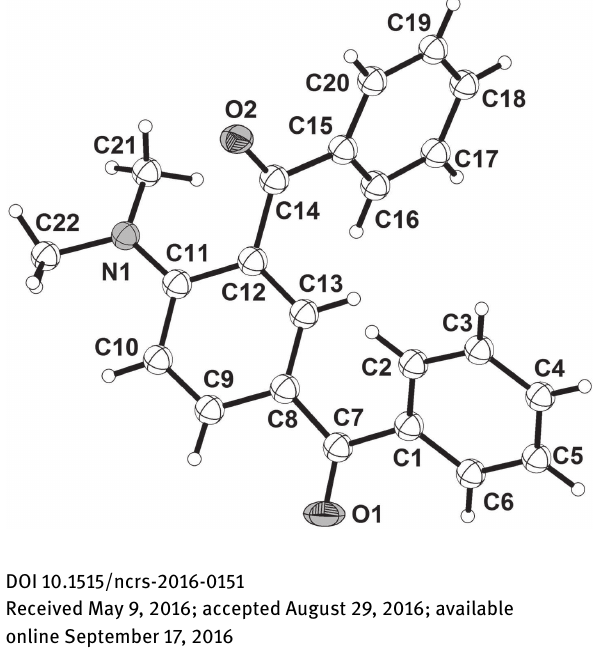
Table 1: Data collection and handling.